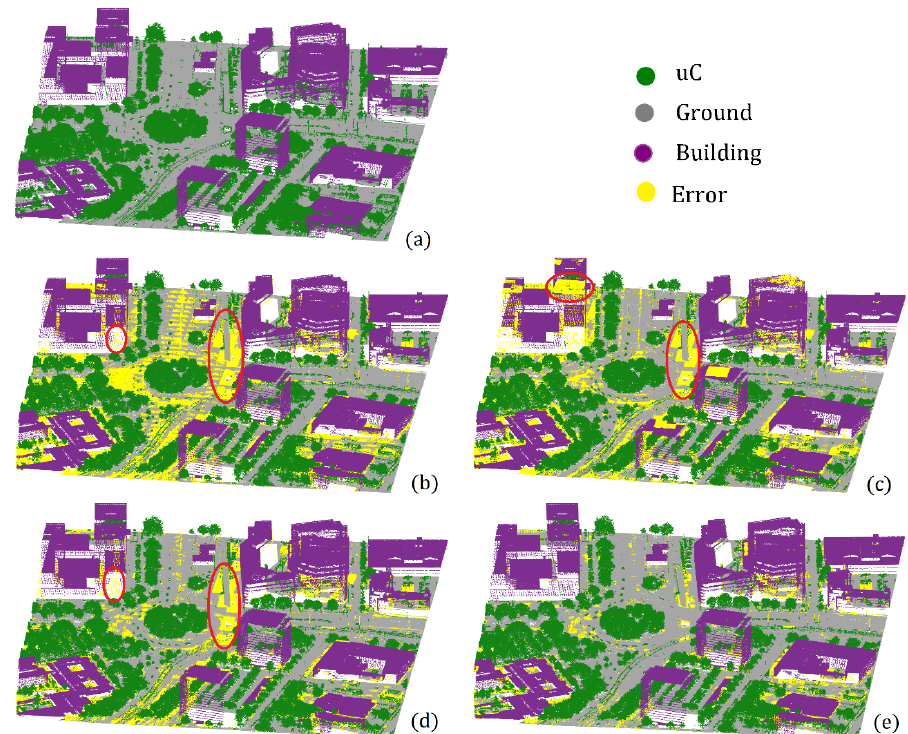
Figure 4. Classification results (misclassified points in yellow) for the AHN test data set: (a) ground-truth, (b) train/test split, (c) bootstrap, (d) k CV, and (e) k CV-B. Many building and ground points are misclassified in red